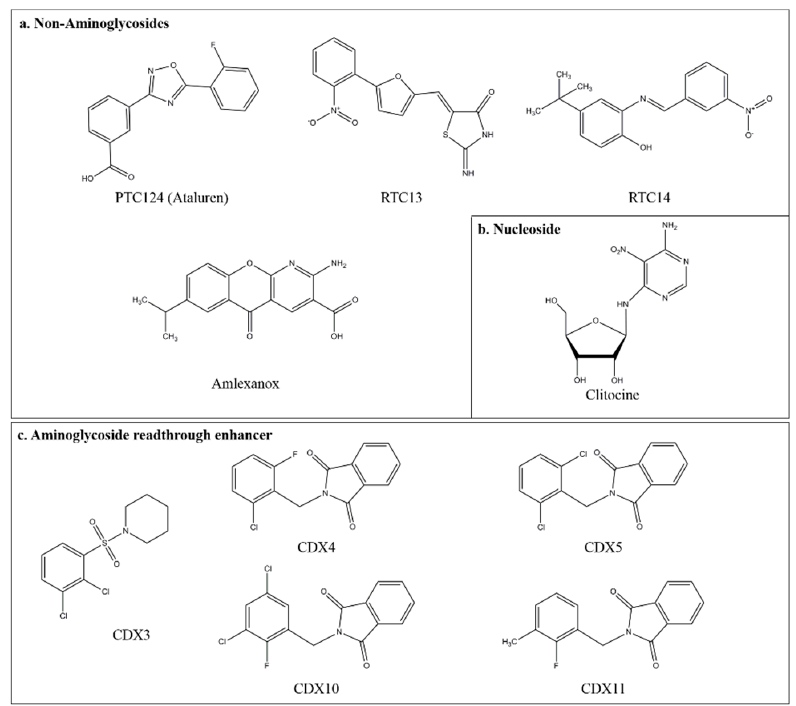
Figure 3. Chemical structure of compounds with nonsense suppression properties and aminoglycoside readthrough